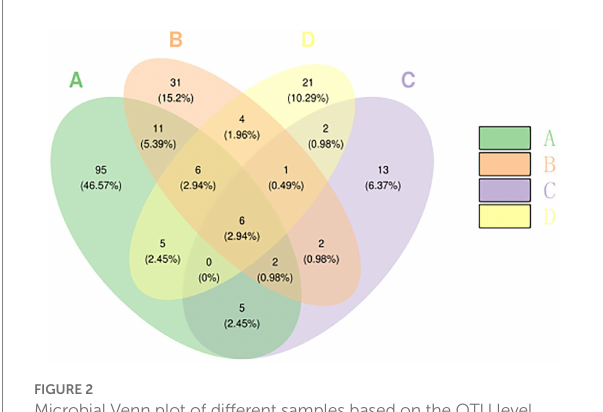
FIGURE 2 Microbial Venn plot of different samples based on the OTU level. Each ellipse represents a sample (group). The overlapping area between the ellipses indicates the common OTUs between the samples (group), and the number of each block indicates the number of OTUs contained in the block. OTU, operational taxonomic